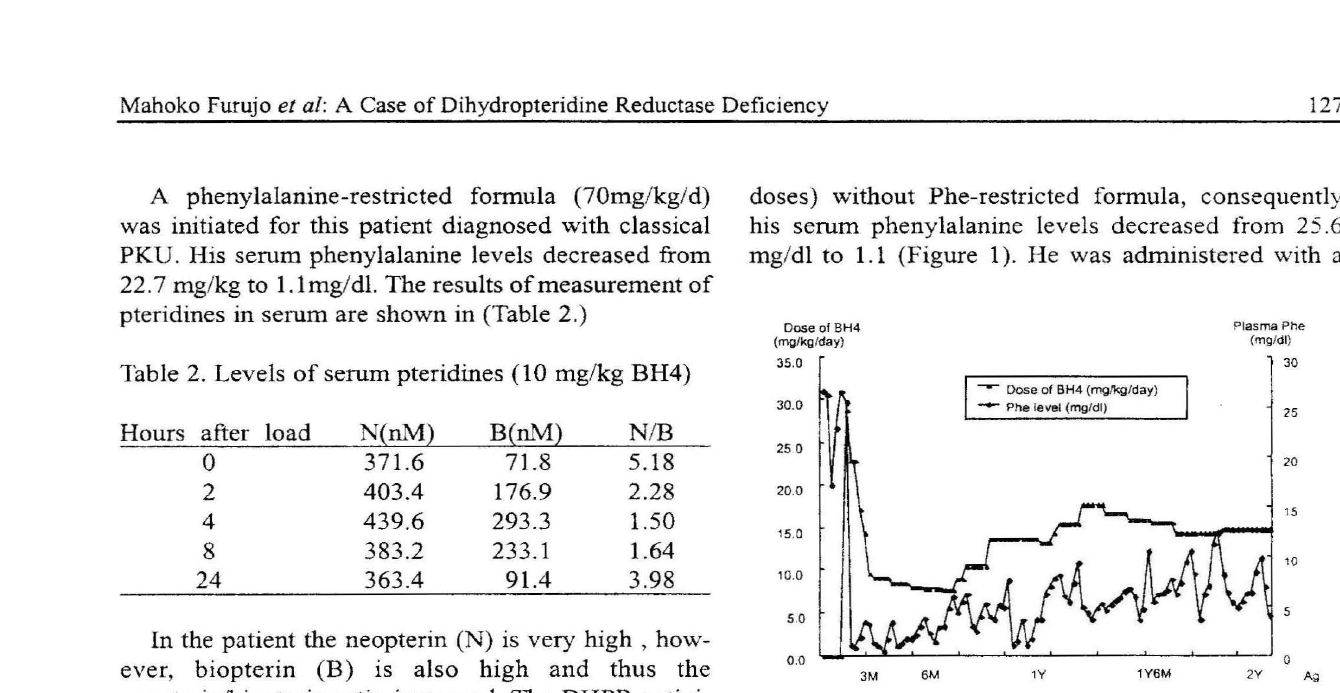
Figure 1. Profiles of plasma Phe level and adminis tered doses of BH 4 . daily dosage of 10-15 mg/kg of BH4. After BH4 thera 5HlAA did not increase (Table 4). At the age of 10